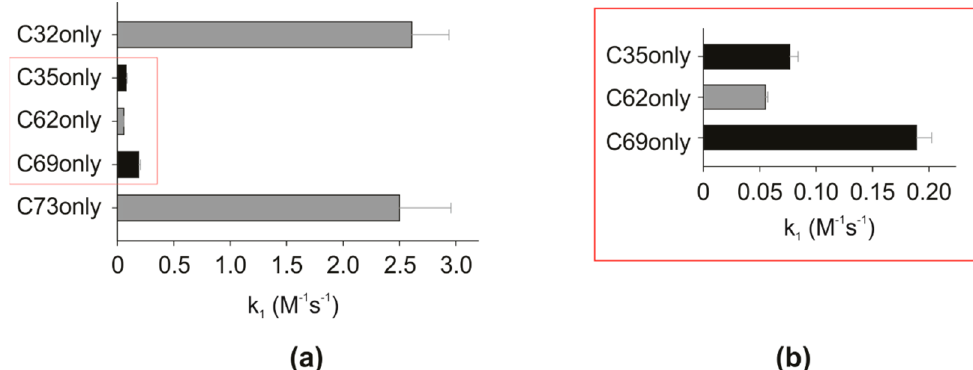
Figure 2. S-nitrosation reaction rate constants for each mutant: ( a ) C32only and C73only mutants stand out as the most reactive in the presence of GSNO; ( b ) the 10× zoom of the general graph, which makes it possible to observe the less reactive mutants C35only, C62only, and C69only. Mutants order according to decreasing reactivity is C32only, C73only, C69only, C35only, and C62only. The experimental error analysis was conducted from the global fitting of multiple curves ( n = 1) with different concentrations of GSNO. The error bar refers to the standard deviation (SD).